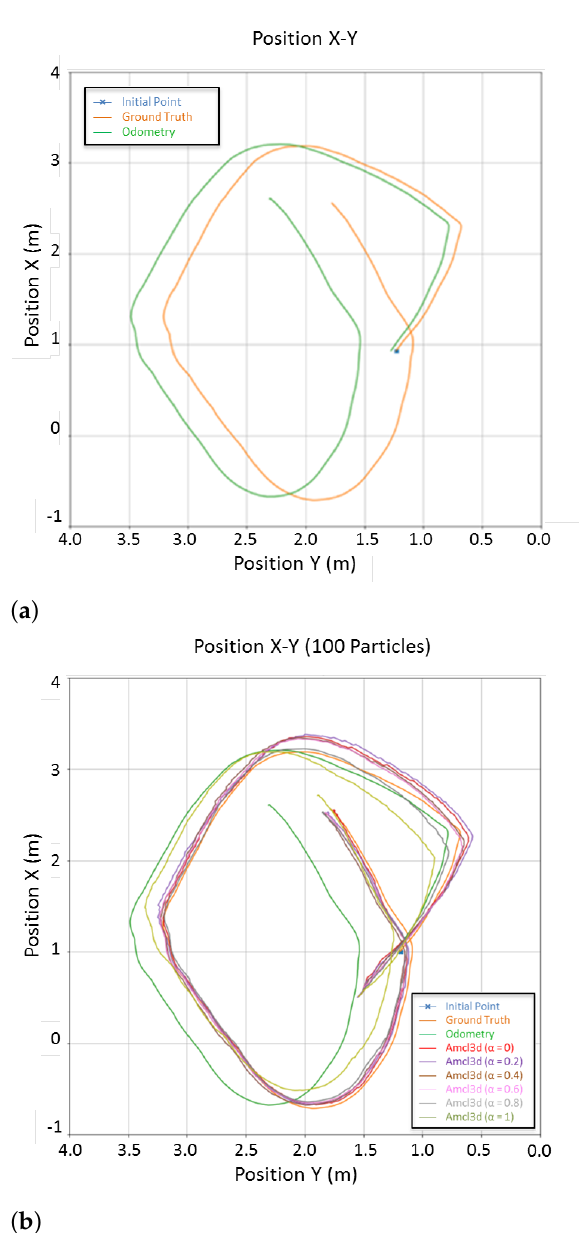
Figure 7. ( a ) Input odometry with artificial drift. ( b ) Results provided by the algorithm in